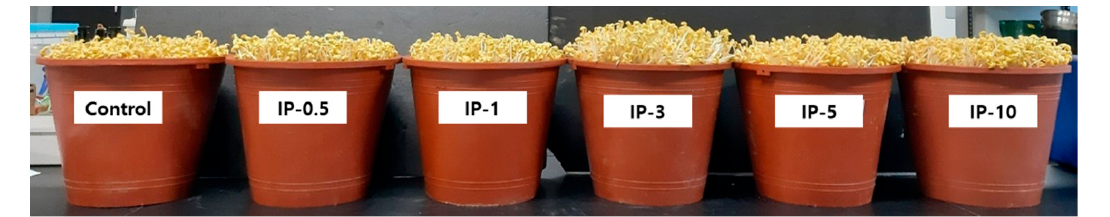
Figure 1. Soybean sprouts grown with different concentrations of illite. Samples are defined in Table 1.